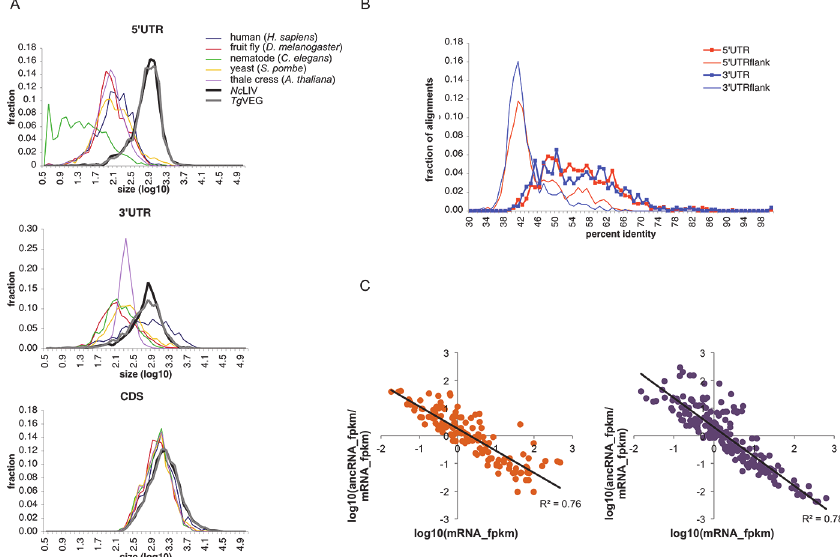
Fig 3. Long untranslated regions and putative anti-sense non-coding RNAs in Tg VEG and Nc LIV. (A) Length distribution of 5 ’ UTRs, 3 ’ UTRs and CDS in Toxoplasma gondii , Neospora caninum , Schizosaccharomyces pombe , Arabidopsis thaliana , Caenorhabditis elegans , Drosophila melanogaster and Homo sapiens . 5 ’ UTRs are found to be strikingly large in the parasites, almost 4 times higher than other eukaryotes. 3 ’ UTRs are comparable to those in human and longer than other eukaryotes. (B) Sequence conservation across UTRs and their flanking intergenic regions. UTR regions are generally more conserved than their flanking intergenic regions. (C) Log abundance ratio of antisense non-coding RNA (ancRNA) and sense coding mRNA pair versus sense coding RNA. There is an inverse relation between abundances of ancRNA and their sense mRNA